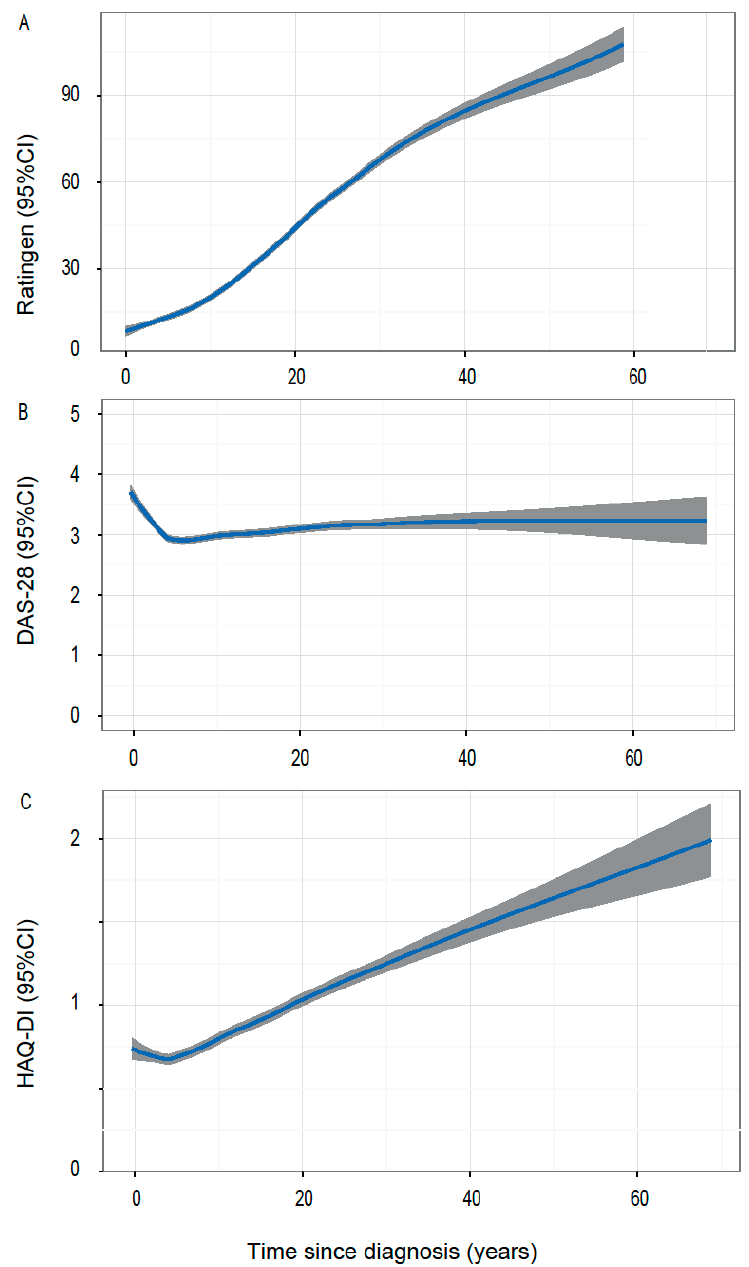
Figure 2. Smoothed time trends for radiographic damage, disease activity, and patient centred outcome: ( A ) Ratingen scores, ( B ) DAS28 scores, and ( C ) Health assessment questionnaire-disability index (HAQ-DI) scores in dependence of disease duration as modelled by local polynomial regression using a smoothing parameter of 0.5. Results are shown with 95% confidence intervals (CI, grey shade).